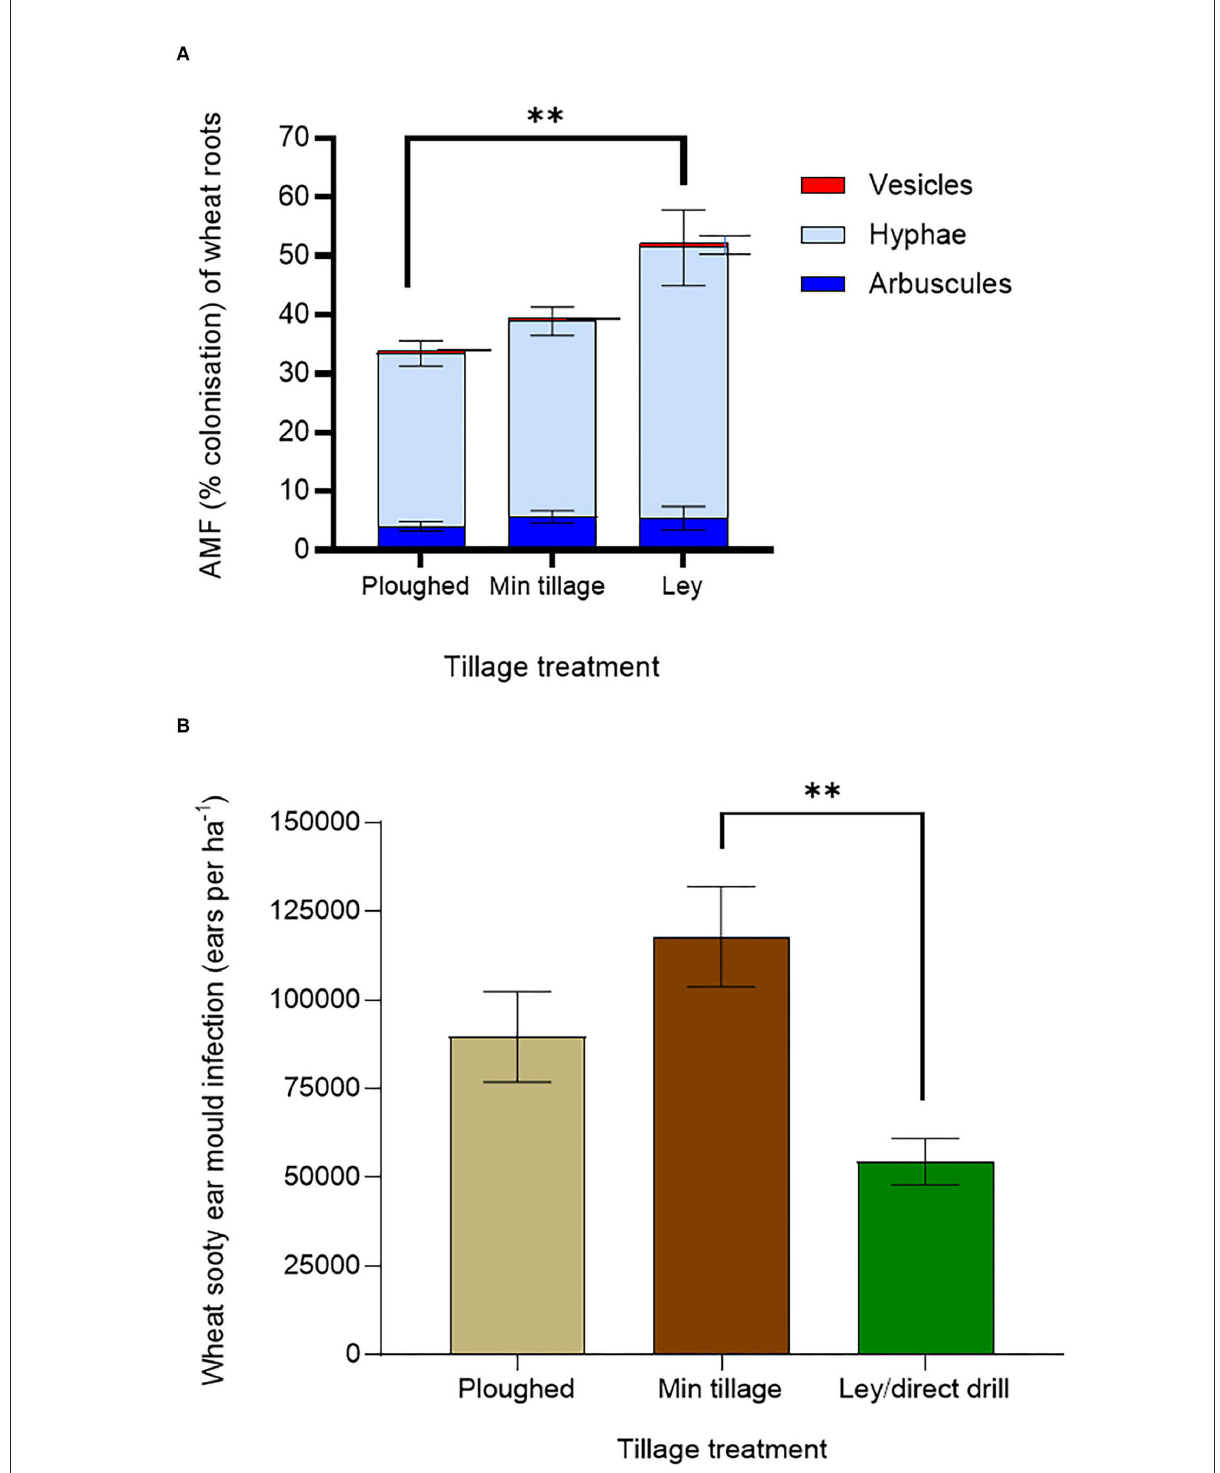
FIGURE3 Effects of ploughing, disc- cultivation, and direct drilling into a 3-year ley, on wheat, averaging across all 6 genotypes, and across the treatments with and without mycorrhiza inoculum added, on (A) AMF colonisation [expressed as % root length colonisation by arbuscules, hyphae, and vesicles (ploughed n = 39, min tillage n = 39, ley n = 5 )] and, (B) sooty ear mould (infected ears ha − 1 ) (ploughed n = 48 , min tillage n = 52 , and ley n = 24). The error bars show ± 1 SE and are displaced to the right for vesicles for clarity. Results of significant Tukey’s HSD test results for differences between means are shown (* p = 0.05; ** p = 0.001; *** p < 0.0001